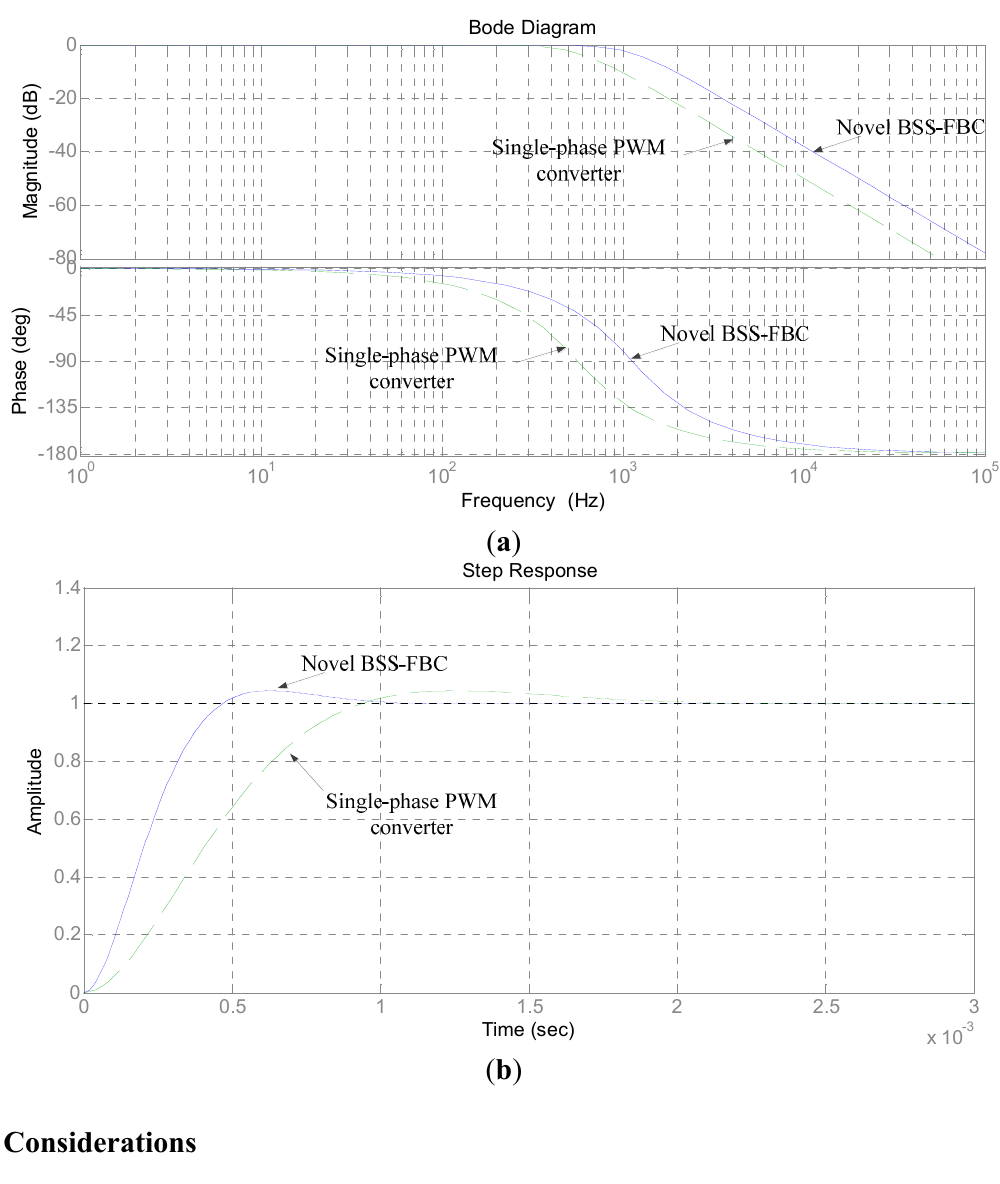
Figure 19. Close loop dynamic characteristics of current loop with compensator for